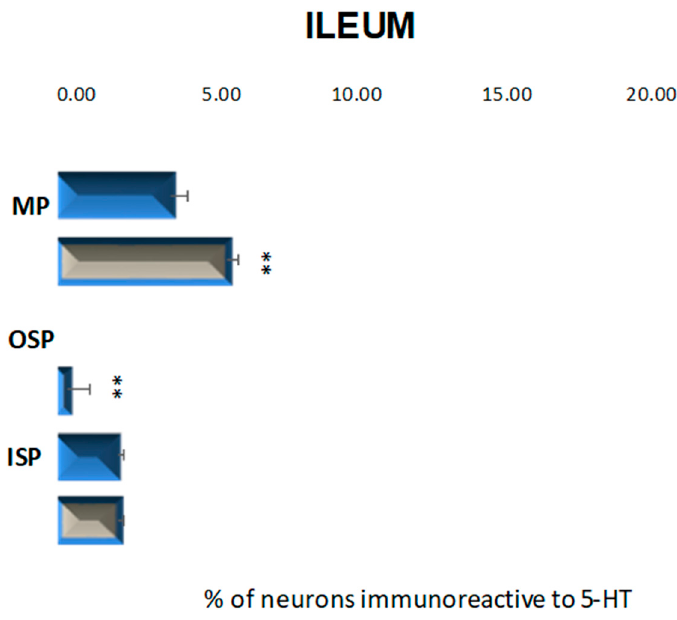
Figure 7. Schematic diagram of the proportion of perikarya immunoreactive to 5-HT of the control (blue bar) and experimental group (grey bars) in the particular parts of ileum. OSP—the outer submucosal plexus; ISP—the inner submucosal plexus; MP—the myenteric plexus. ** p < 0.01 indicates differences between all groups for the same neuronal population.